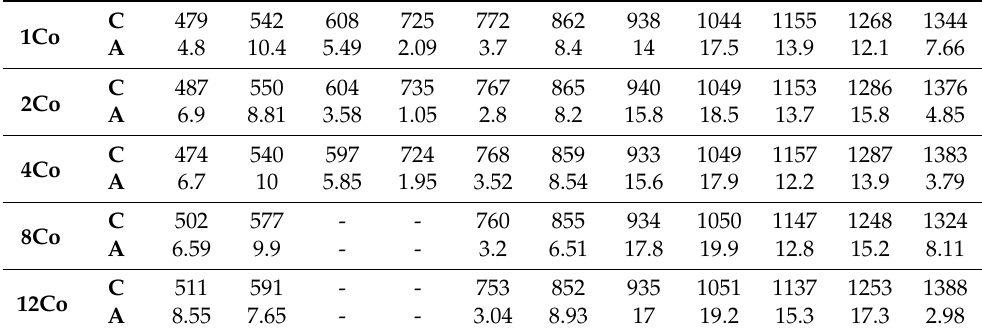
Figure 5. Curve fitting of FTIR spectra of the glasses 42P 2 O 5 –20B 2 O 3 –5Al 2 O 3 –25Na 2 O–8CoO. Table 2. Deconvolution parameters of the glasses and their assignments. C is the center of the band, and A is the relative area (%) of the band.